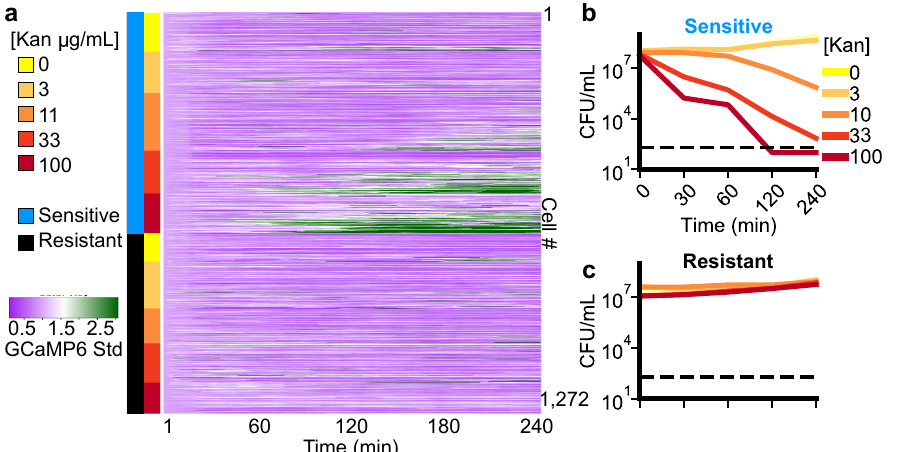
Figure 3. The onset of Ca 2 + transients distinguishes sensitive and resistant cells and is dose and time dependent. ( a ) Heatmap of 1272, single-cell, GCaMP6 std traces (see Figure 1) for sensitive (naive BW25112 cells, blue rows) and Kan resistant (mntH cells, black rows) E. coli treated with different concentrations of kanamycin (second color column; yellow->red). Green shading corresponds to high GCaMP6 std (colorbar) and therefore marks the onset of Ca 2 + transients. ( b , c ) The colony forming units (CFUs) per mL for different exposure periods and concentrations of kanamycin for sensitive ( a ) and resistant ( b ) cells. Colors match the concentration colors in panel a. The limit of detection for our assay is 200 CFUs/mL (dotted black line, see Methods). Values for each concentration and exposure time are the average of 3 biological replicates.